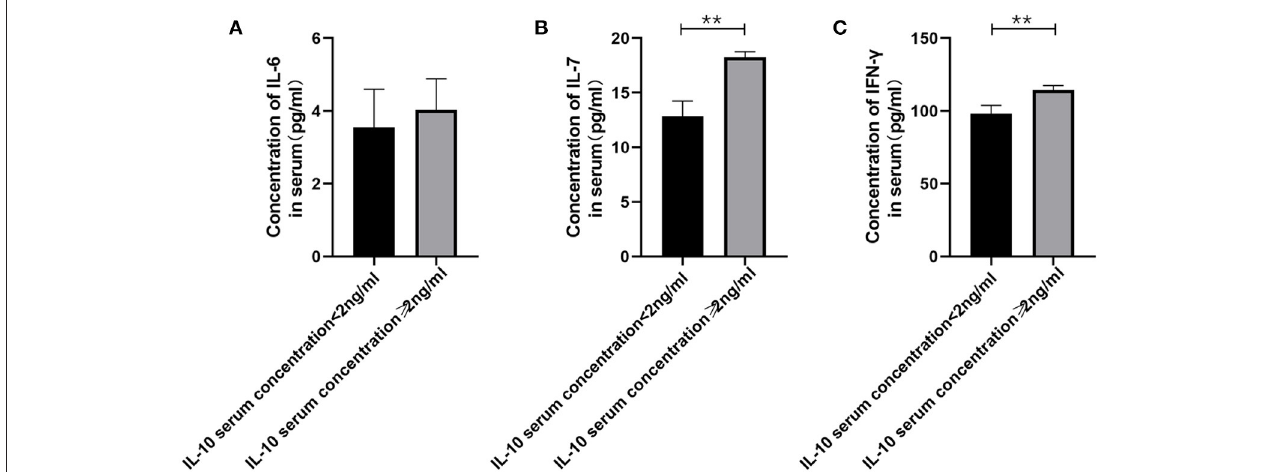
FIGURE 3 | The relationship between IL-10 levels in patients with gMG and the levels of pro-inflammatory cytokines including IL-6, IL-7 and IFN- γ . (A) , patients with high serum IL-10 levels were usually accompanied by higher IL-6 concentration, but there was no significant difference in serum IL-6 levels between patients with high IL-10 levels and low IL-10 levels ( p = 0.443). (B) , Generalized MG patients with low IL-10 levels were usually accompanied by a significant decrease in IL-7 levels ( p < 0.001). (C) , Generalized MG patients with low IL-10 levels were usually accompanied by a significant decrease in IFN- γ levels ( p = 0.001). The data were shown as mean with ± SD of each group, *means p < 0.05, **means p < 0.01. N = 5 for each group within gMG patients.